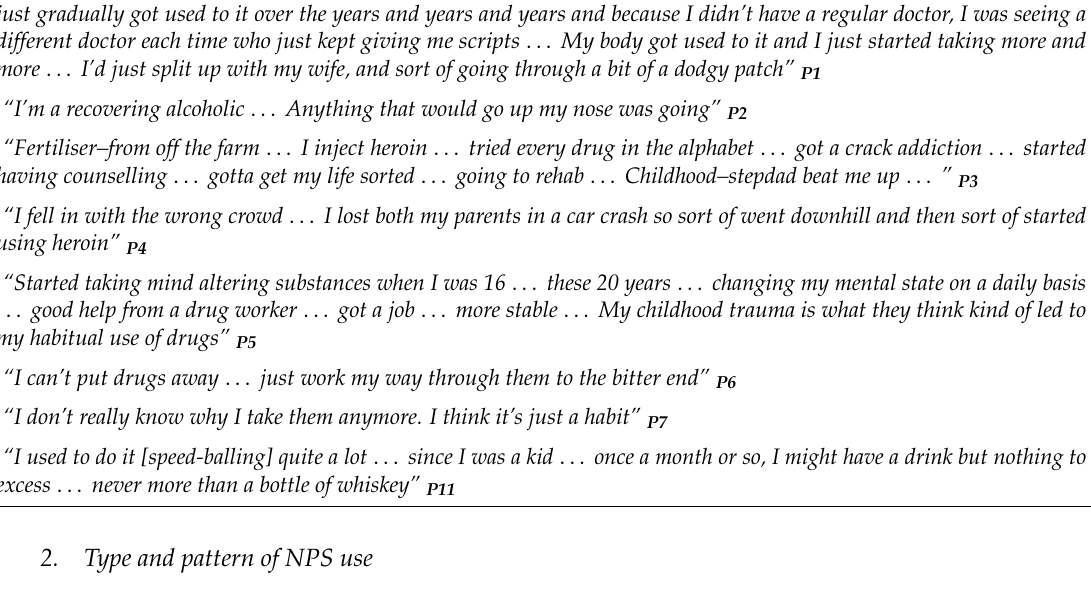
Table 2. Type and pattern of NPS use. A list of all the themes and sub-themes, with respective quotes by